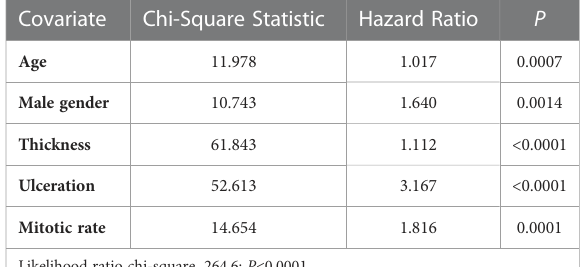
TABLE 3 Effect of mitotic rate as a binary variable on melanoma- speci fi c mortality.